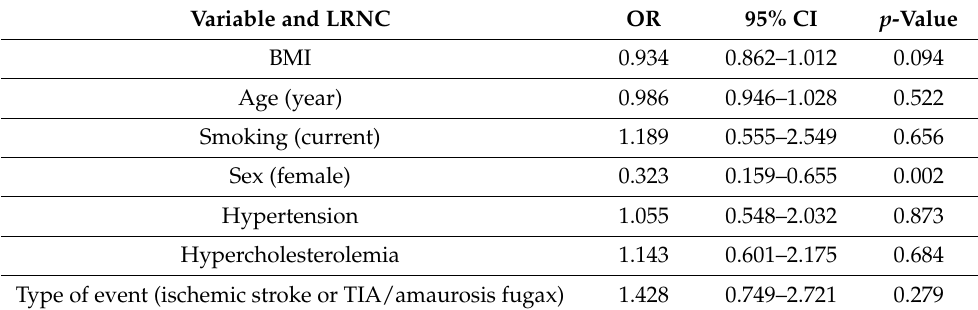
Table 4. Univariate logistic regression for LRNC and several baseline variables.